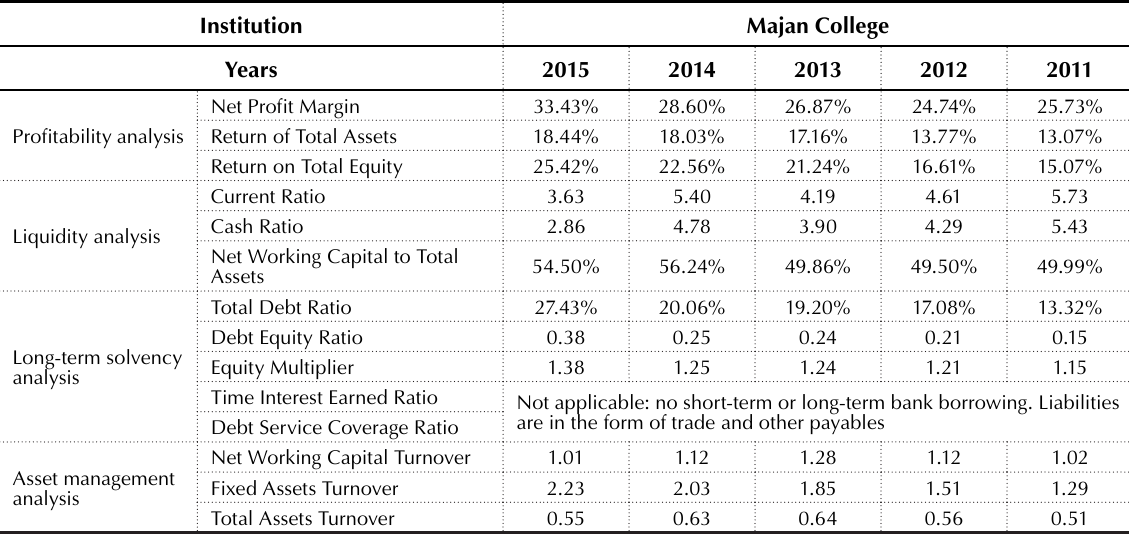
Table 5. Five years financial ratios analysis for Majan